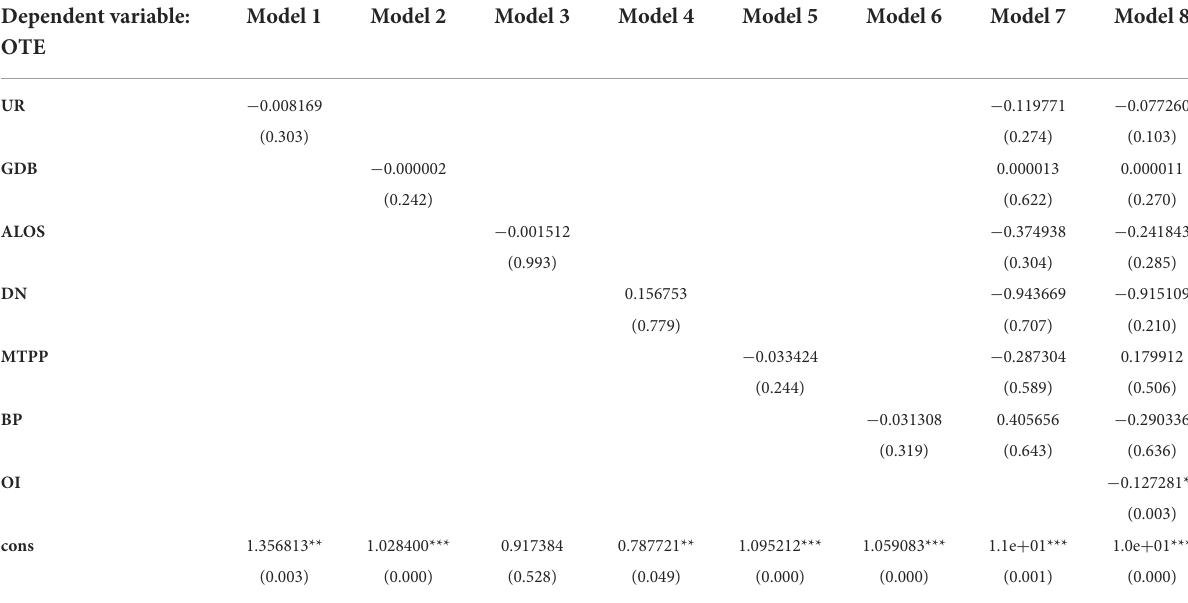
TABLE 9 Results of bootstrapping truncated regression for secondary